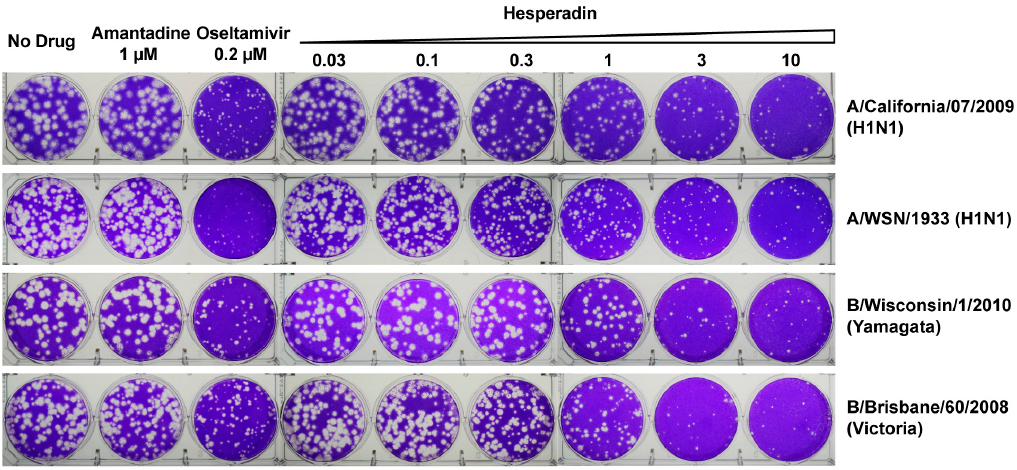
Figure 2. Plaque assays of hesperadin in inhibiting influenza A and B viruses. The assay was carried out with MDCK cells. Plaque areas were determined by Image J at each concentration, and the data was fit into a dose-response curve with Prism 5. The best fit EC 50 values are shown in Table 1. The plaque assay was tested in duplicate at each drug concentration.